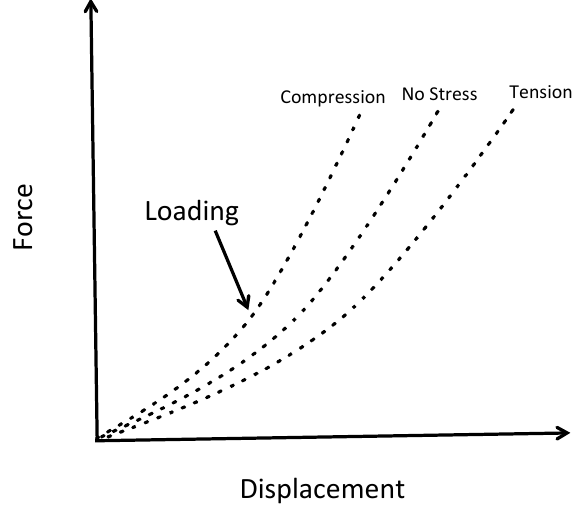
Figure 18. Nano-indentation used to measure residual stress.